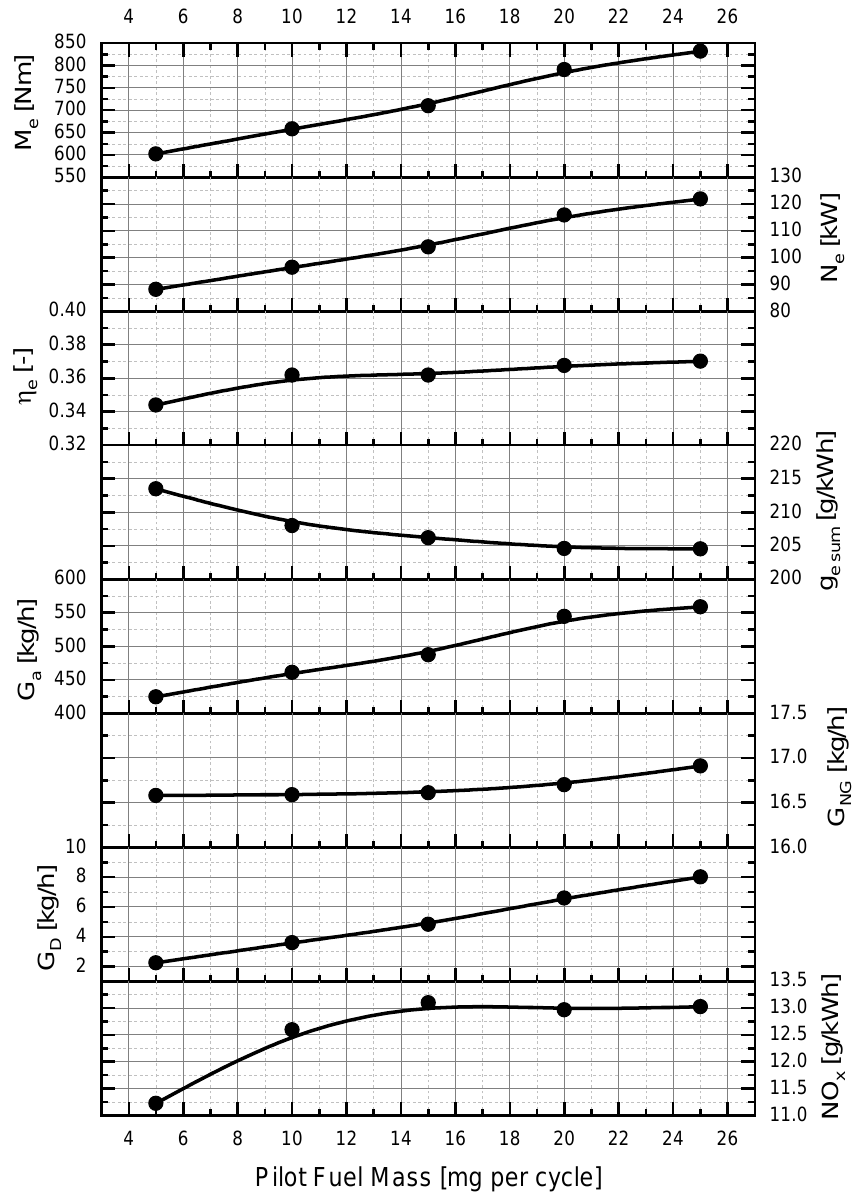
Figure 2. Engine parameters versus pilot fuel mass (n = 1400 rpm). M e , brake torque; N e , brake power; η e , brake efficiency; g e sum , total brake specific fuel consumption of both fuels; G a , air mass flow; G NG , Natural gas mass flow; G d , diesel fuel mass flow; NO x , nitrogen oxides brake specific emissions.